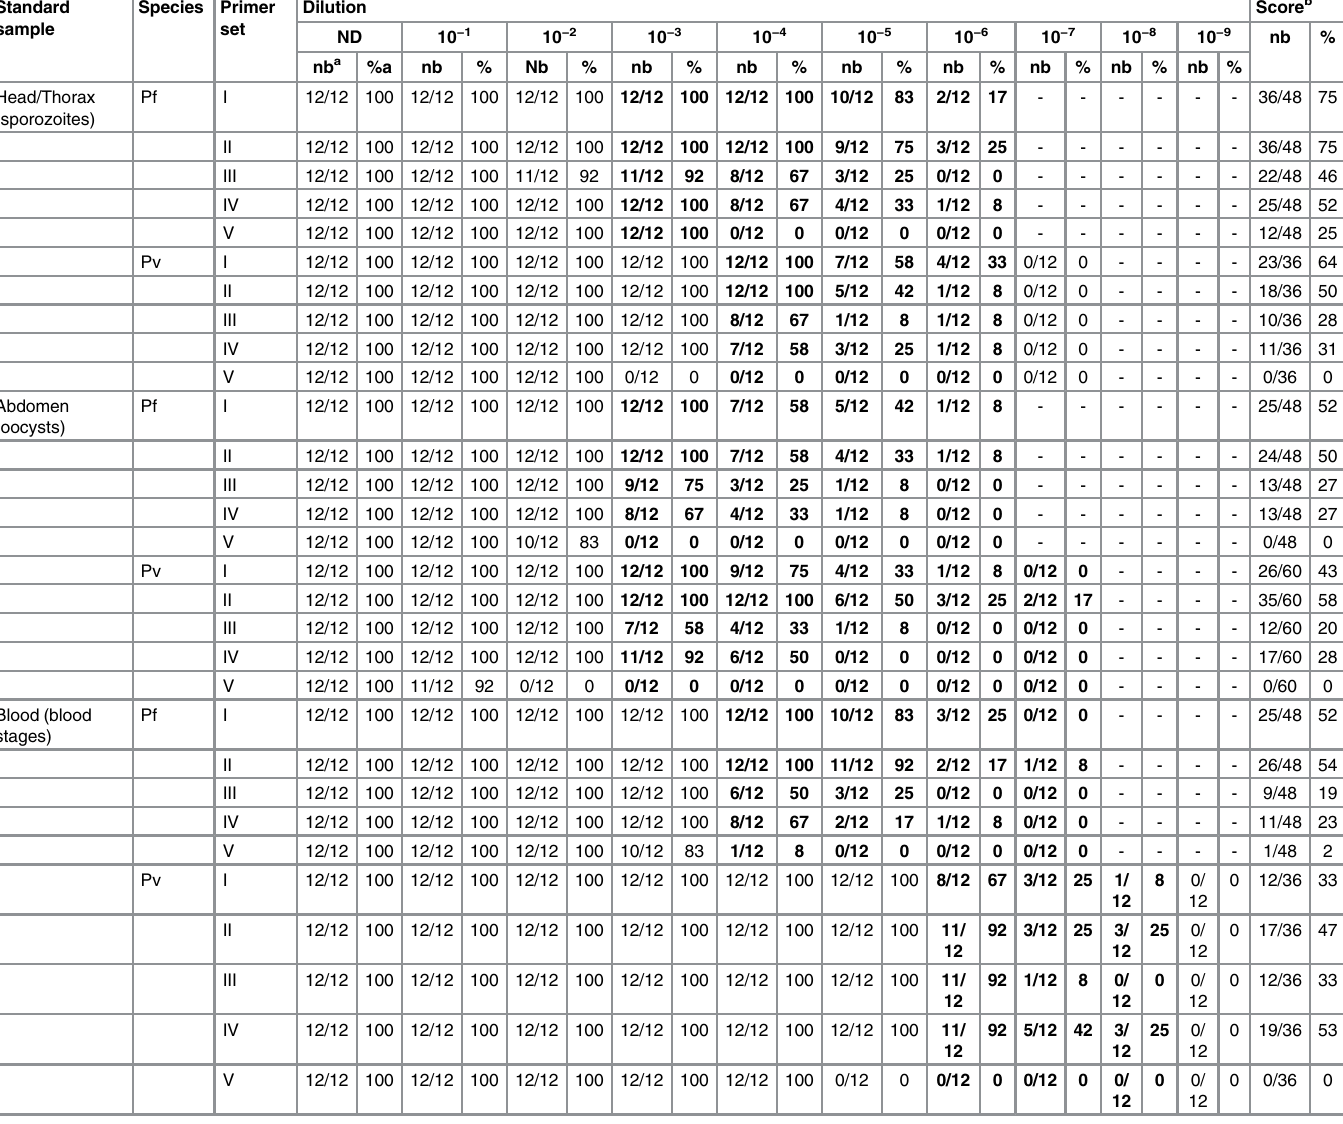
Table 3. Results of the assessment of each primer set on sporozoites, oocysts and blood stages standards. Standard Species Primer sample set